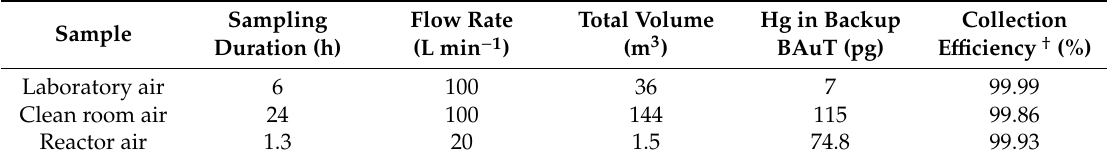
Table 1. Results of the total gaseous mercury (TGM) breakthrough test.